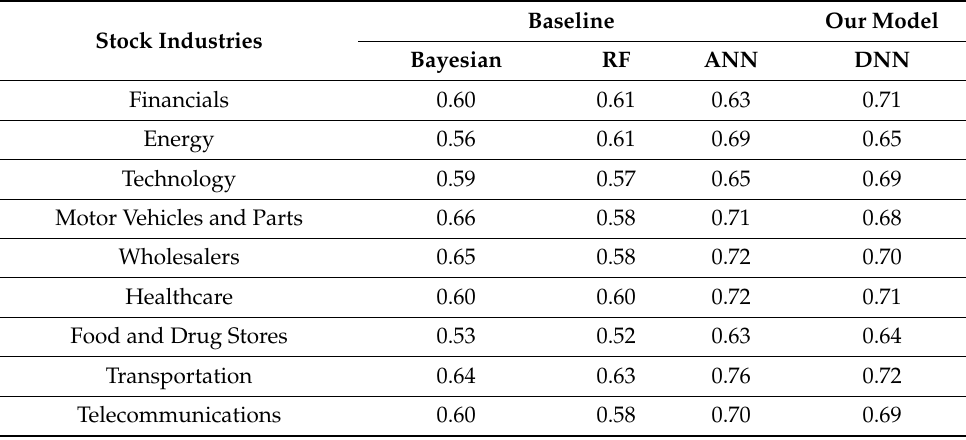
Figure 7. Cross-correlation analysis results for multi-scale coefficients. Table 3. Comparisons results with other algorithms in F1